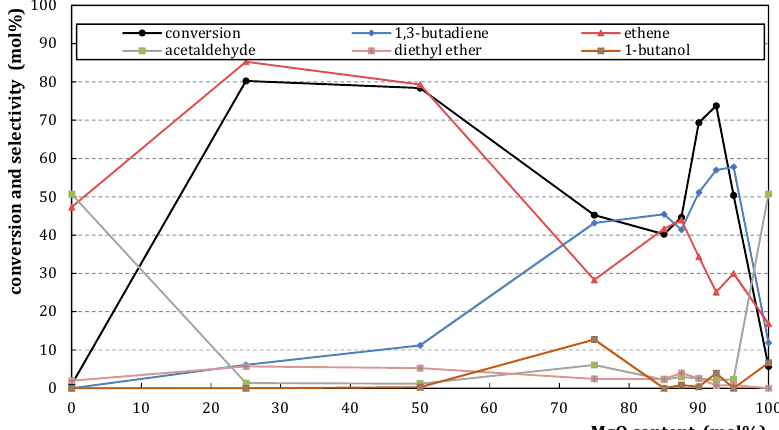
Figure 6. Results of catalytic testing of precursors M1 and SiO 2 and binary M1/SiO 2 mixed oxides with different molar composition; each produced according to Section 3.2. ( m cat = 500 mg; weight hourly space velocity (WHSV) = 1.2–1.8 h − 1 ; T = 450 °C; p = 5.5 bar(a); (cid:1848)(cid:4662) (cid:2898) in favor of clarity.